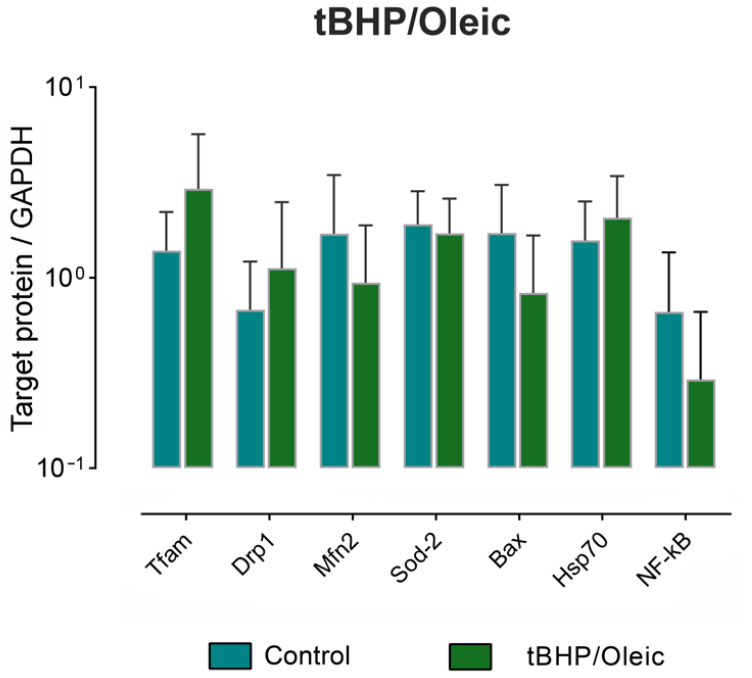
Figure 4. The level of protein production in HepG2 cell model with the addition of tBHP/Oleic; Mean ± SD; *— p < 0.05.